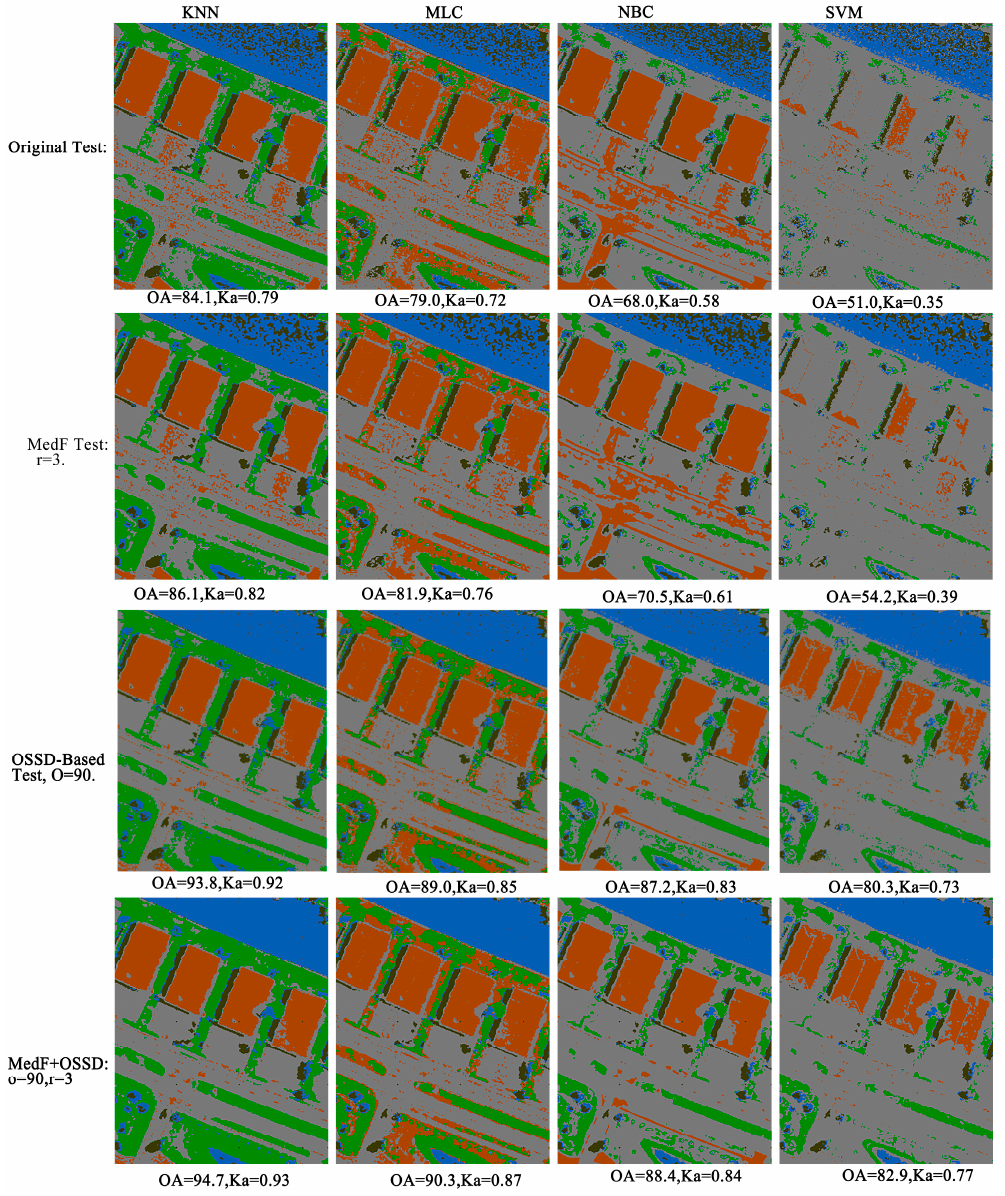
Figure 7. Classification results (aerial image); The first column , the second column , the third column and the fourth column are the classification maps for KNN, MLC, NBC, and SVM, respectively. Original test: image without any processing; MedF Test: the image is processed only with the median filter, r = 3 × 3; OSSD-based test: the image is decomposed with O = 90; OSSD + MedF Test: the image is classified by the proposed system, with parameters O = 90 and r = 3 × 3. The value of OA is given in percentage.